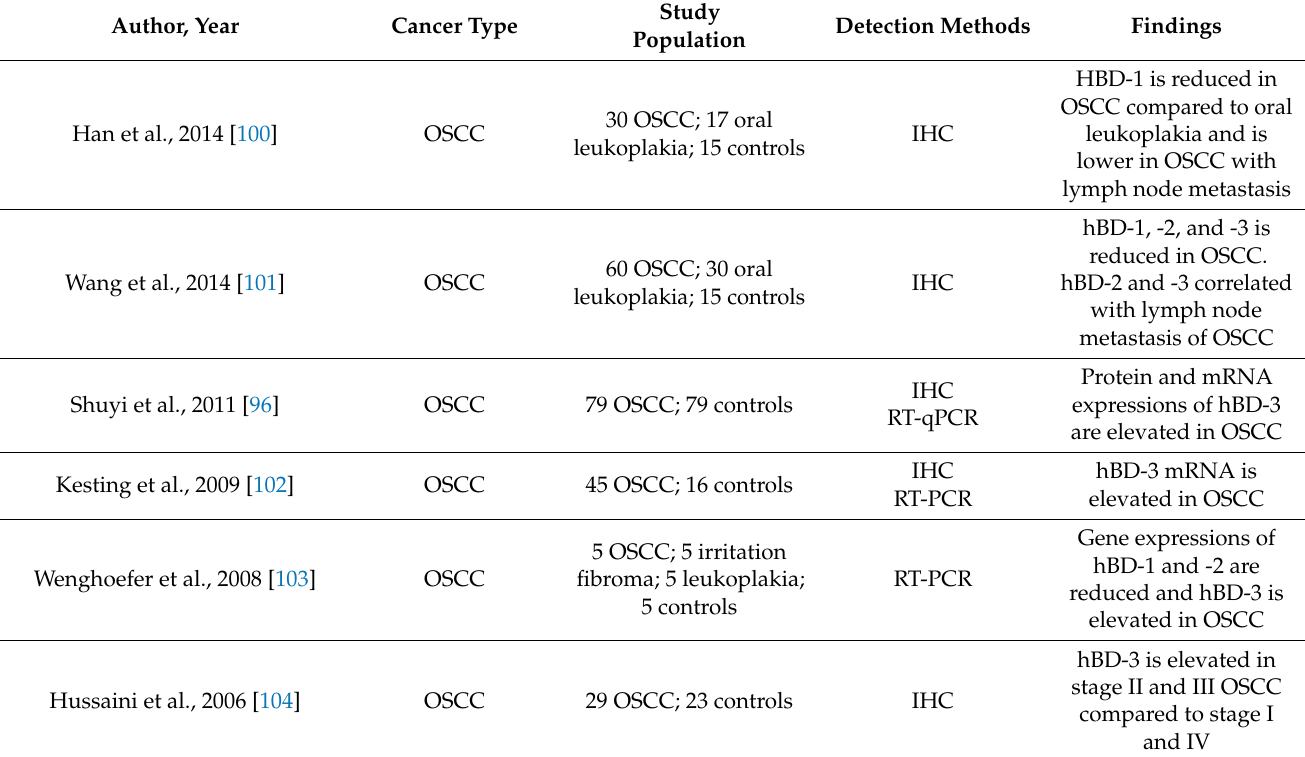
Table 1. Summary of the clinical studies evaluating the hBD levels in head and neck cancer patients.